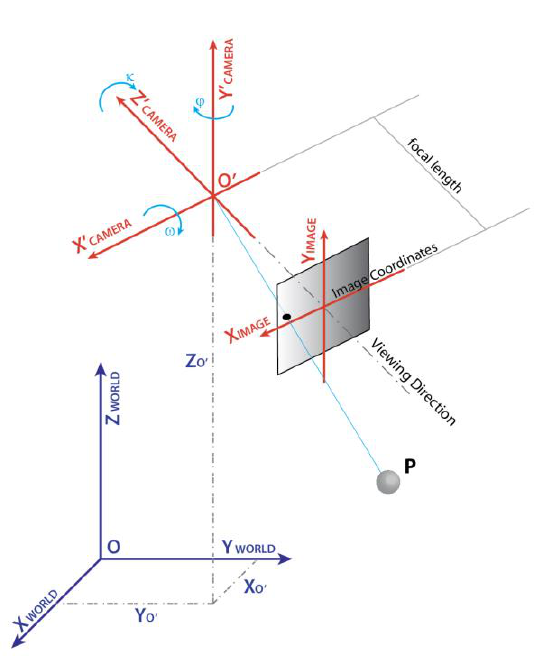
Figure 3. Two Reference Systems (RS): world-RS (O,XYZ) and the camera-RS